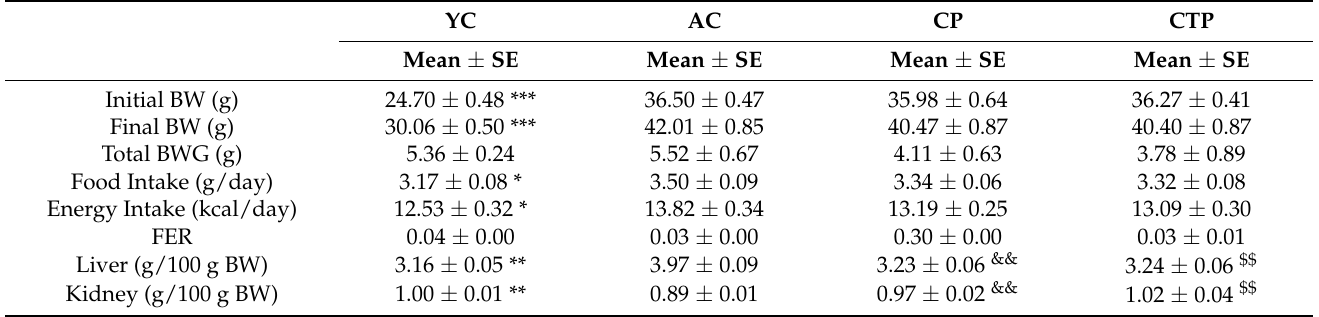
Table 1. Effect of a 12-week supplementation of CP and CTP on body weight gain, food intake, food efficiency ratio, and organ